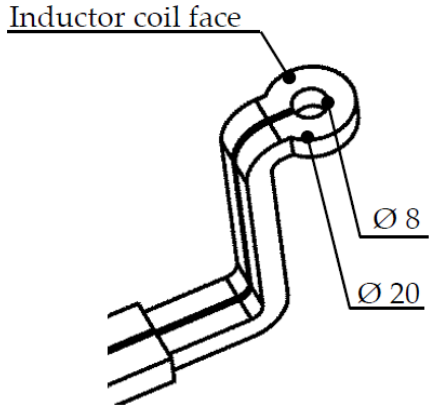
Figure 2. Partial sectional view from induction coil, all dimensions are in mm.